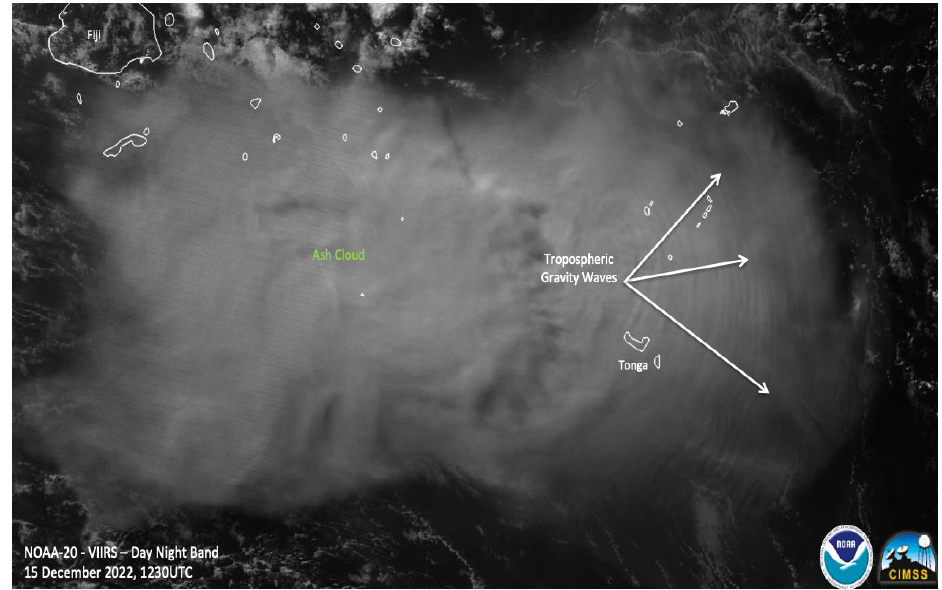
Figure 8. The ash clouds and the tropospheric gravity waves from the Tonga Volcano as observed by the VIIRS DNB.